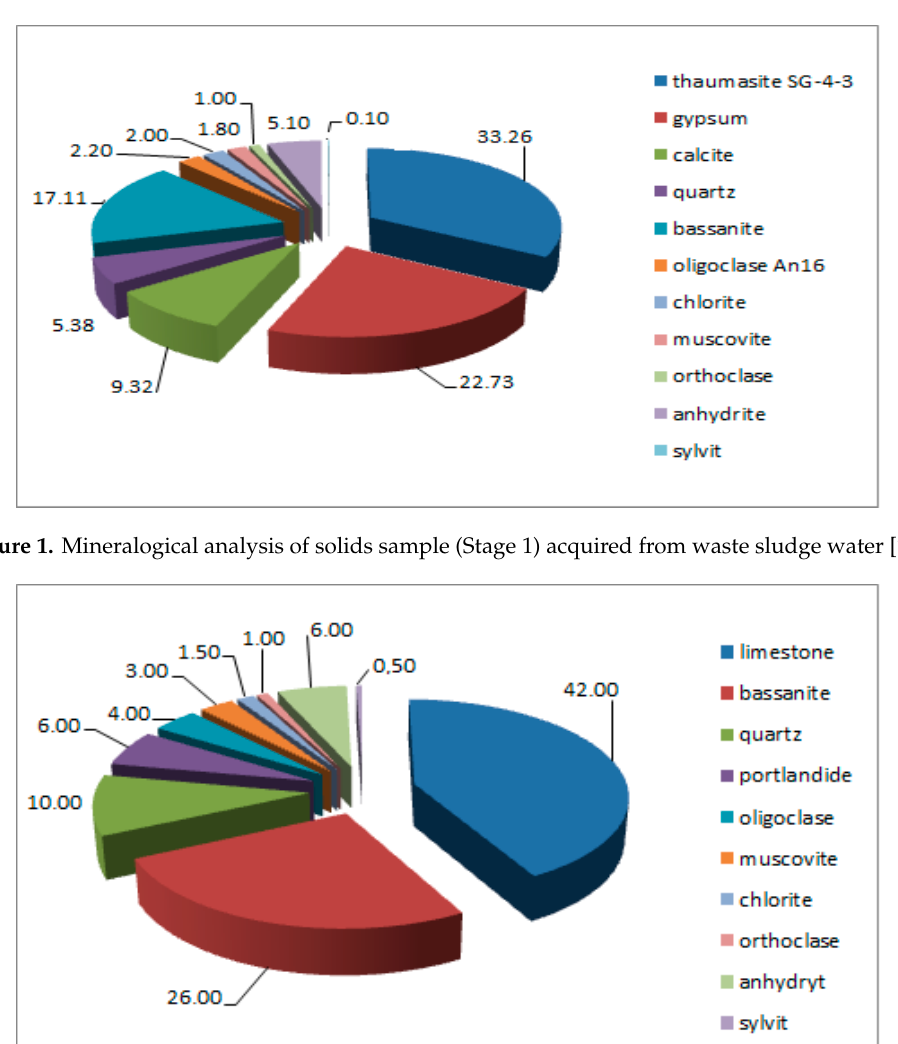
Table 3. Consistency of fresh mixture.